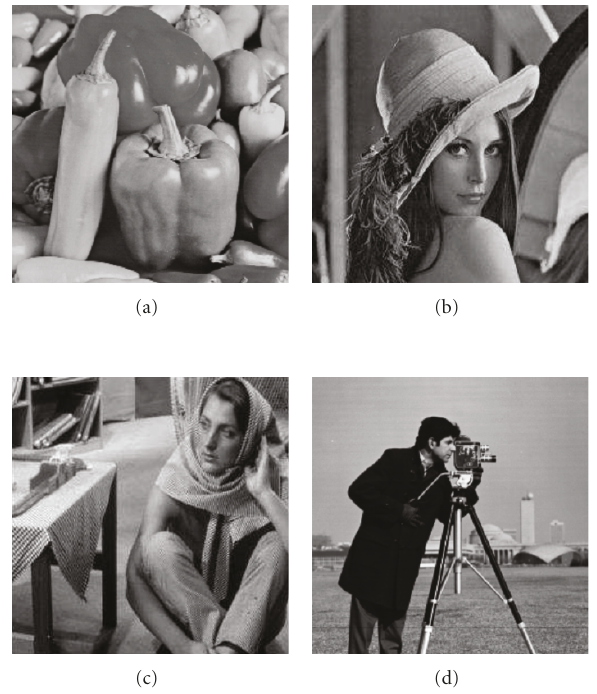
Figure 6: Test images. From top left, clockwise: Peppers, Lena, Cameraman, and